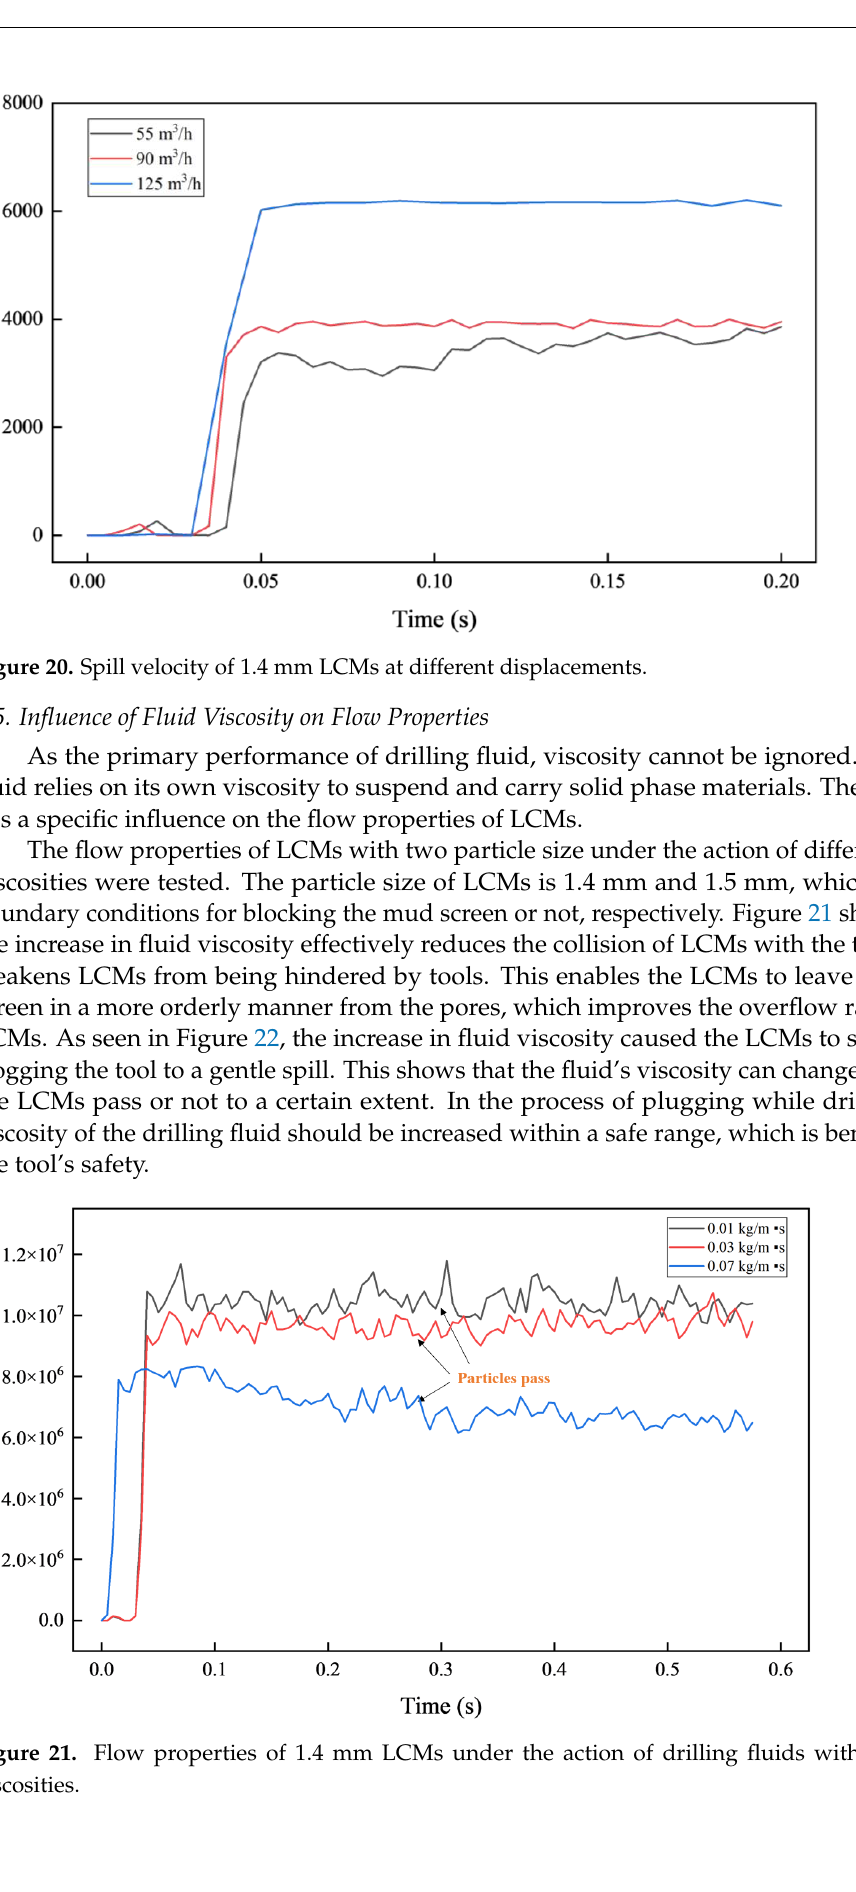
Figure 19. The magnitude of the pulling force of 1.4 mm LCMs at different displacements.